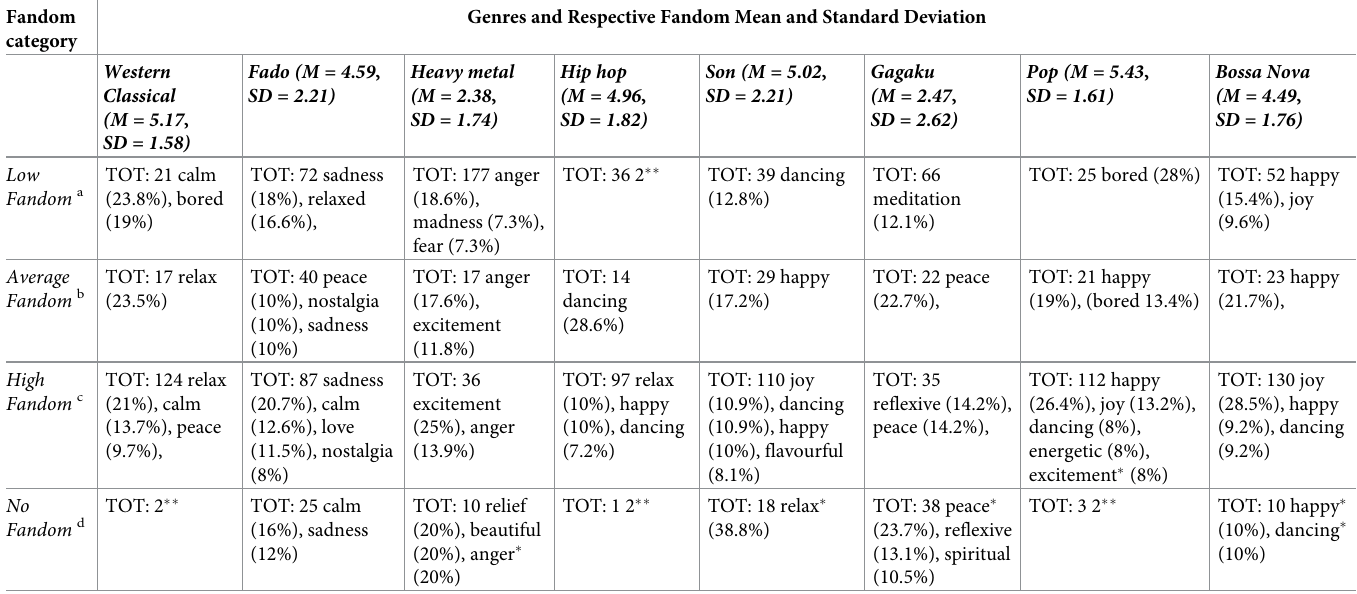
Table 3. Emotions reported above 5% of the total emotion words reported for each genre label in phase 1 by fandom rating category from phase 2. Fandom Genres and Respective Fandom Mean and Standard Deviation category Western